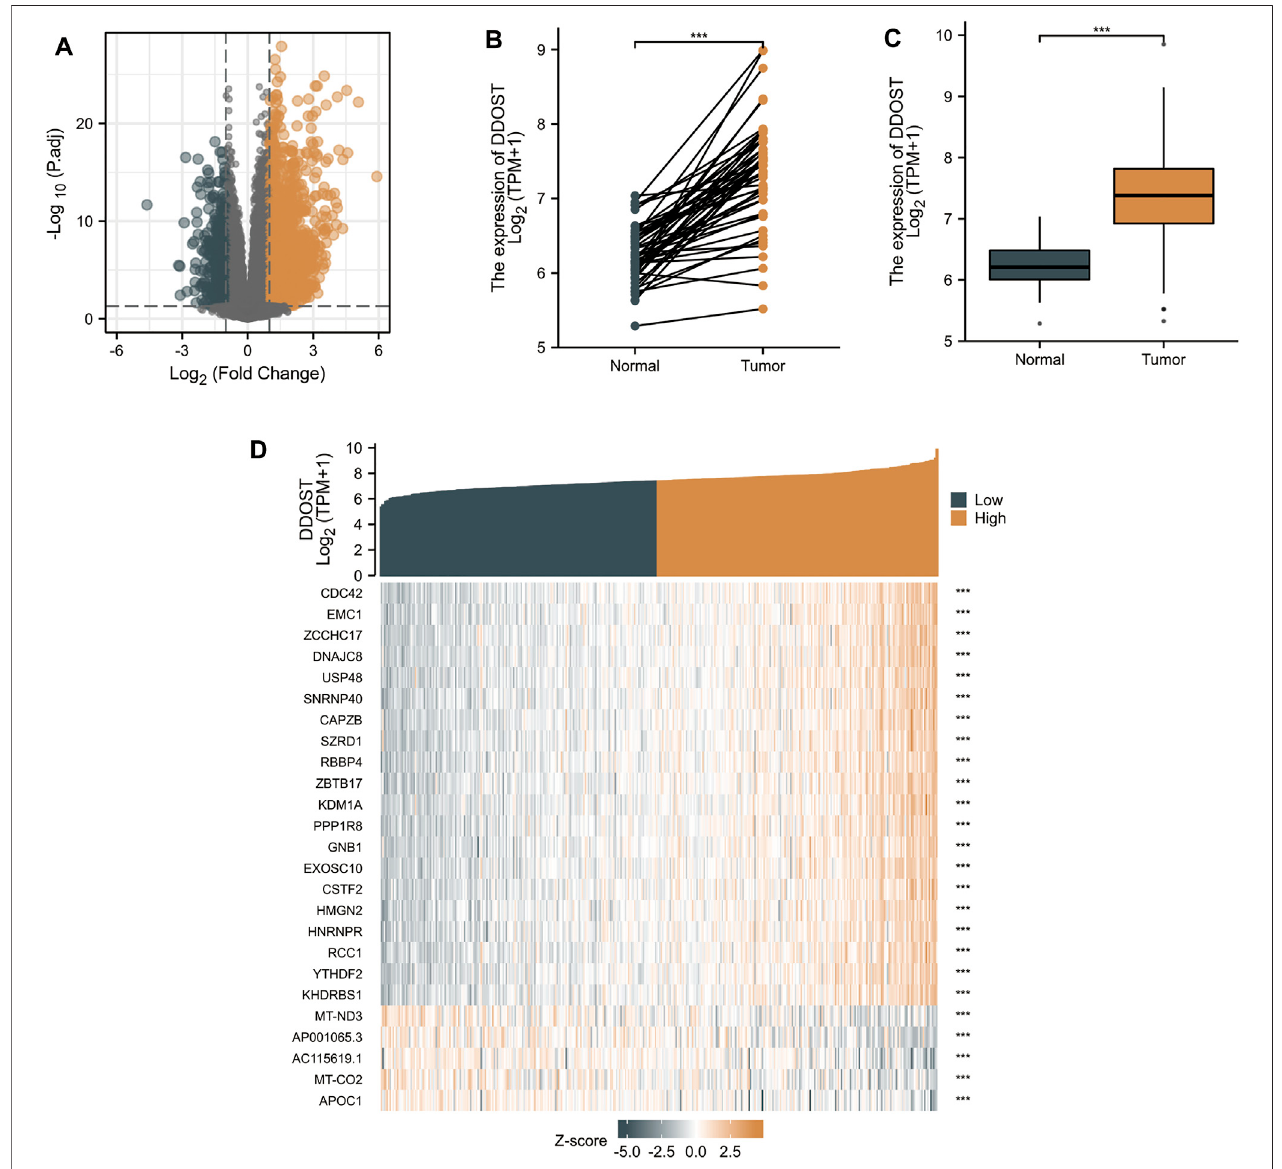
FIGURE 1 | The results of differentially expressed gene (DEG) analysis. (A) The volcano plot of differentially expressed RNAs. (B,C) The different expressions of DDOST between HCC and the normal group. (D) The heat map of the 25 genes correlated to DDOST.